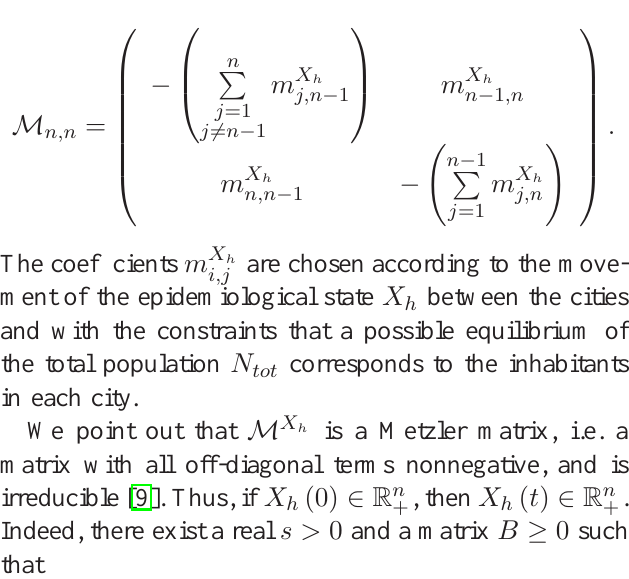
Fig. 1. A general n-patches model for the transmission of the Chikungunya virus between n cities in R´eunion